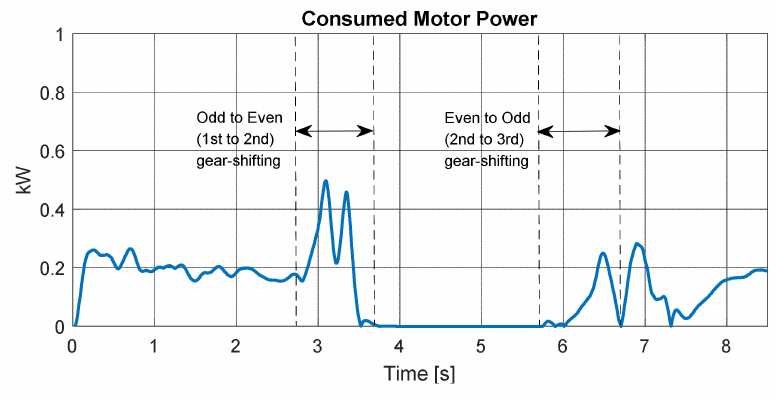
Figure 17. Consumed motor power during